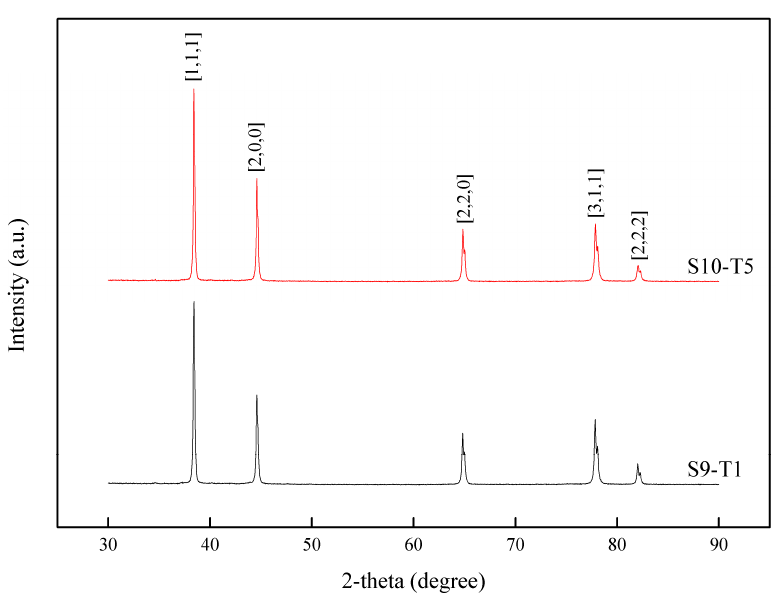
Figure 11. XRD spectra of recycled specimen for S9-T1 and S10-T5.